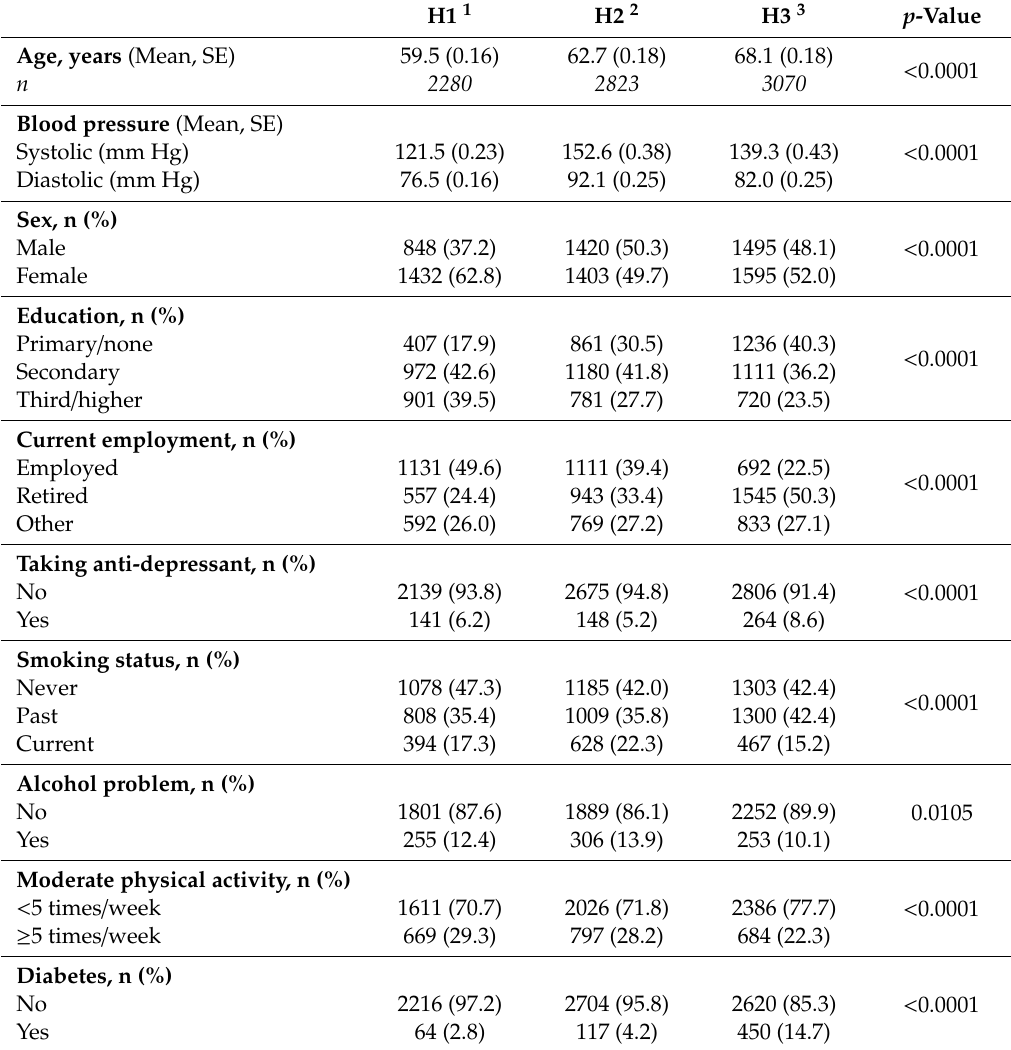
Table 1. Comparison of socio-demographic and health characteristics of participants at Wave 1 using analysis of variance